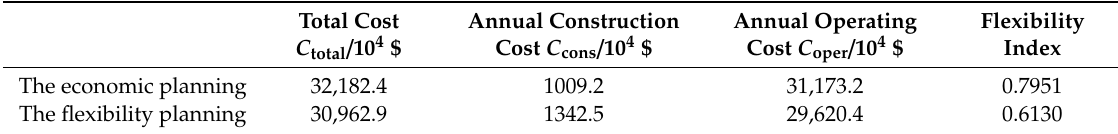
Table 1. Comparison of planning scheme results in typical